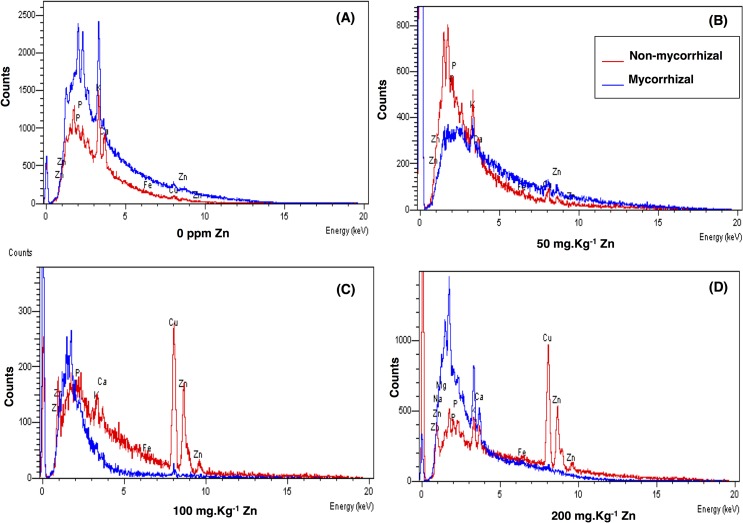
EDX spectra of wheat grains grown on soils contaminated with different levels of Zn, (A) 0 mg kg-1 Zn; (B) 50 mg kg-1 Zn; (C) 100 mg kg-1 Zn and (D) 200 mg kg-1 Zn.